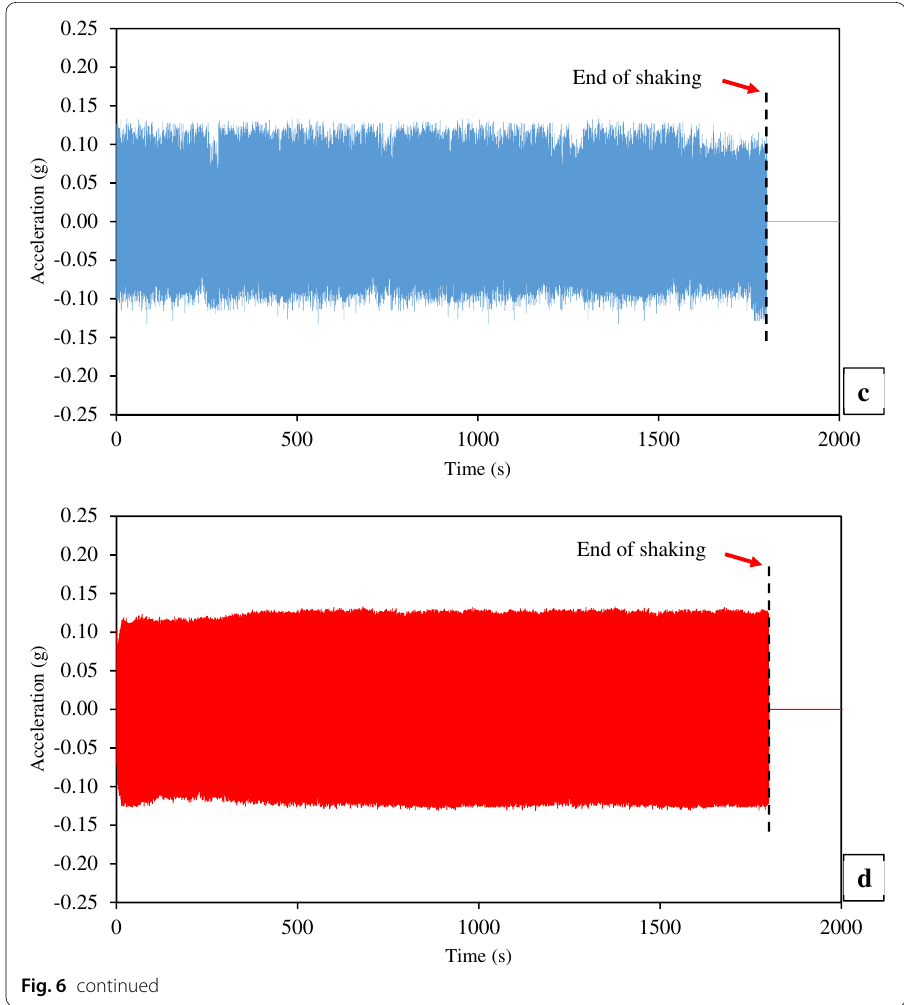
As shown in Fig. 7, the measured horizontal displacements at the intermediate depth of all layers of the thickened tailings were noticed to be increased rapidly and almost similar to each other. Throughout the shaking loading, this behaviour is compatible with the observation of the motion of FLSB by the naked eye. However, the detailed observa- tion of the recorded data shows that during shaking, the upper layer has slightly larger horizontal displacement than the lower or bottom layers. For example, the measured horizontal displacement in the top layer after 4.5 s of shaking is 10% larger than that recorded in the bottom layer. The reason for measuring relatively small lateral displace- ments is related to the type of fine materials (densified fine tailings) used and the rela- tively low excitation frequency of 1.0. Dynamic amplification is small at low excitation